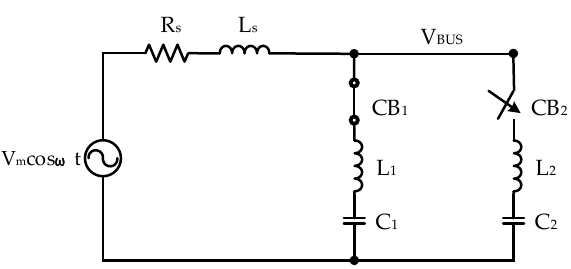
Figure 5. Circuits for back-to-back filter banks energization.